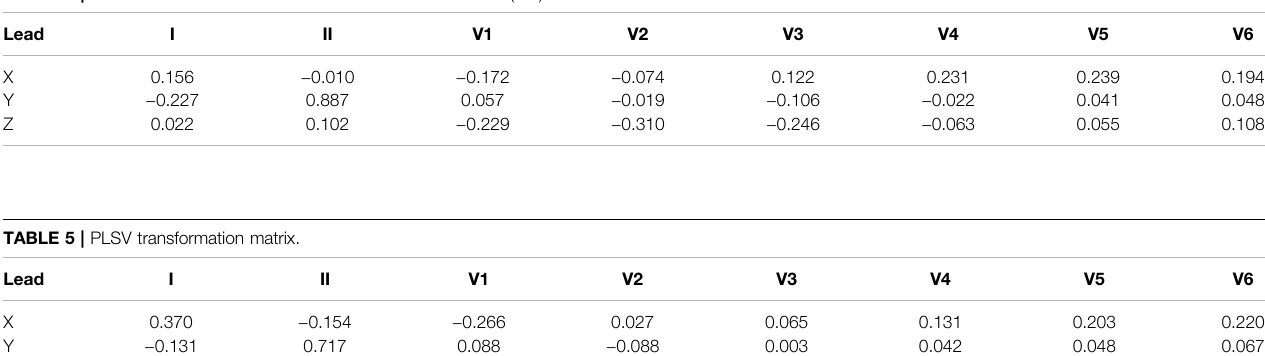
TABLE 4 | Transformation matrix for Inverse Dower transformation (IDT).